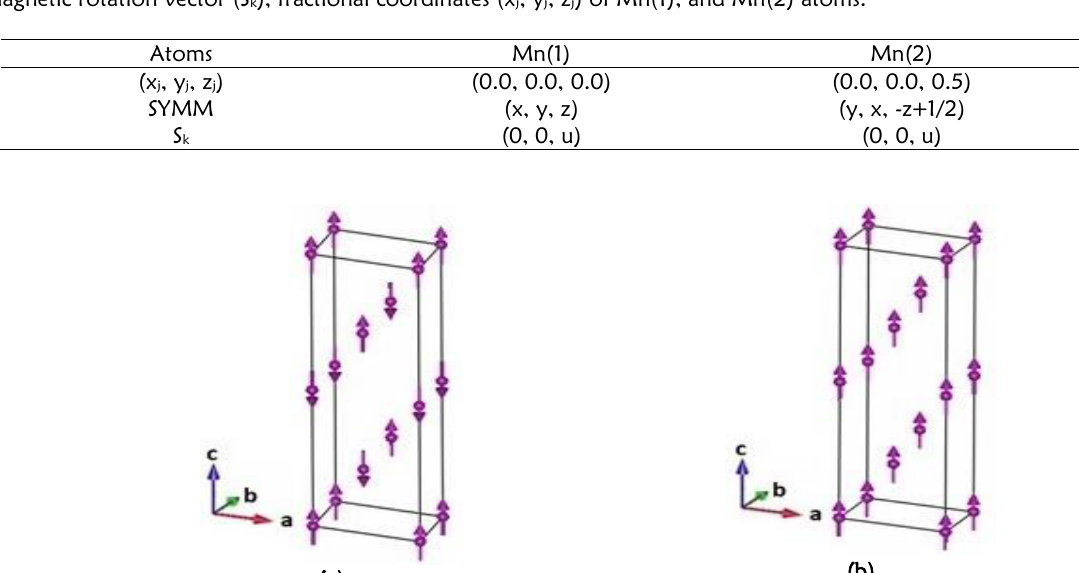
Table 11. Basis functions of Representation IRrep (3) of LaMnO 3 , space group: R-3c, magnetic symmetry (SYMM), magnetic rotation vector (S k ), fractional coordinates (x j , y j , z j ) of Mn(1), and Mn(2) atoms.